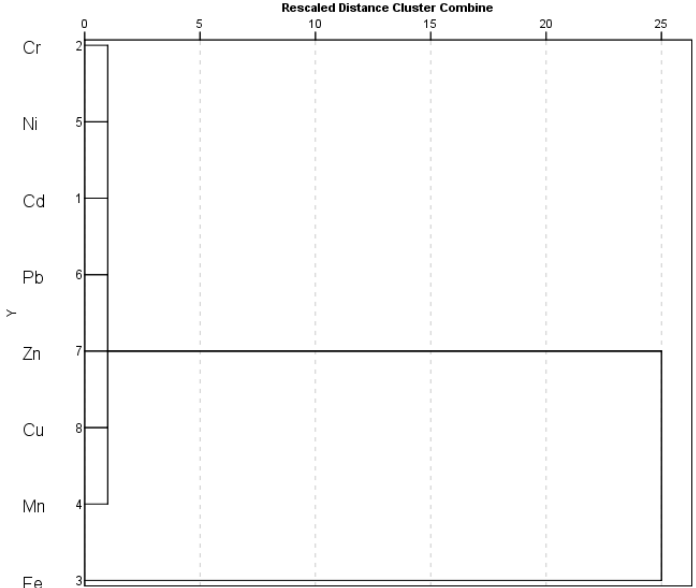
Figure 7. Cluster analysis of metals in soil across the province.